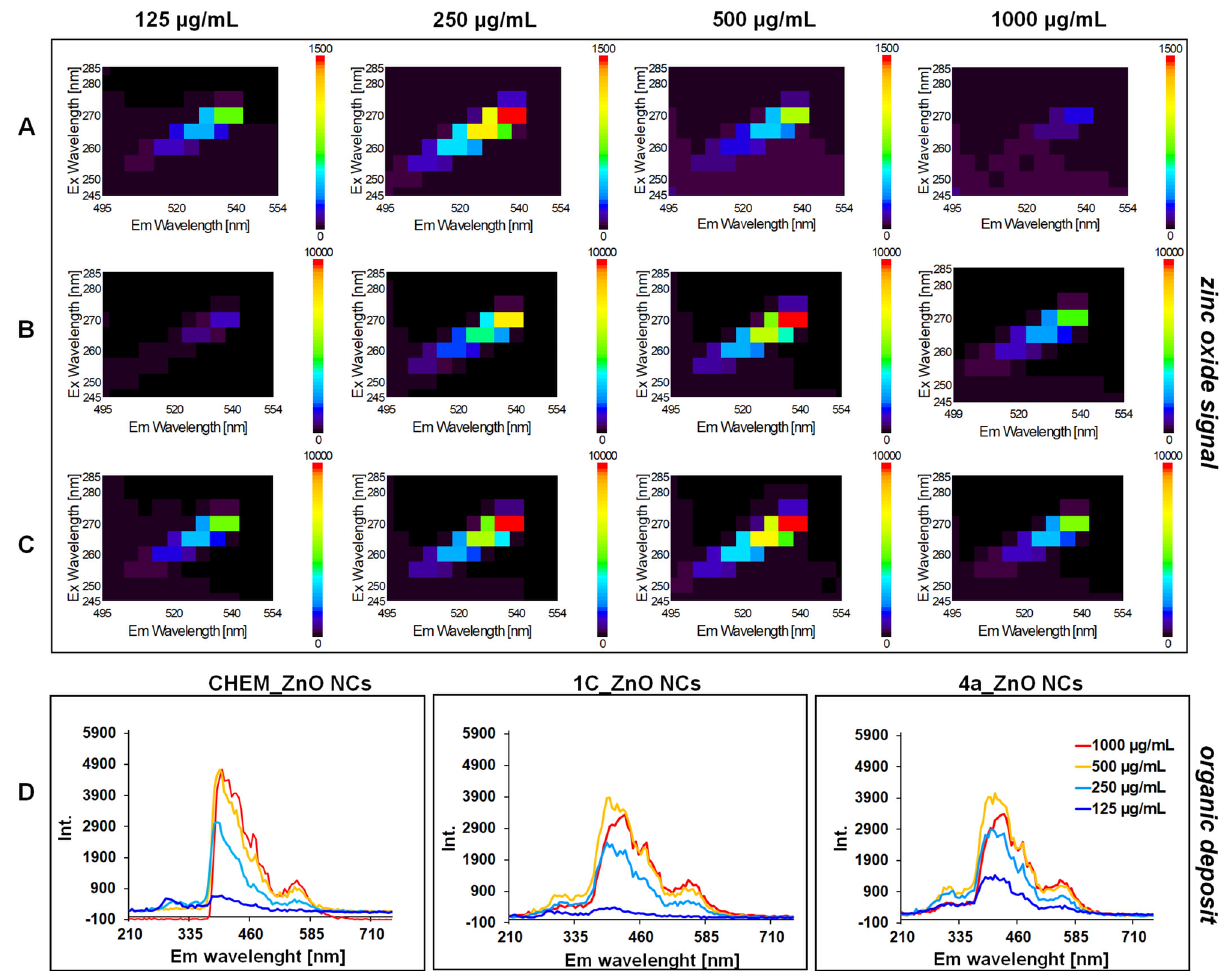
Figure 8. The photoluminescence spectra at two specific excitations regions (λ = 540 nm and λ = 420 nm) for CHEM_ZnO NCs ( A ), 1C_ZnO NCs ( B ) and 4a_ZnO NCs ( C ) at different concentration; organic deposit of tested NCs ( D